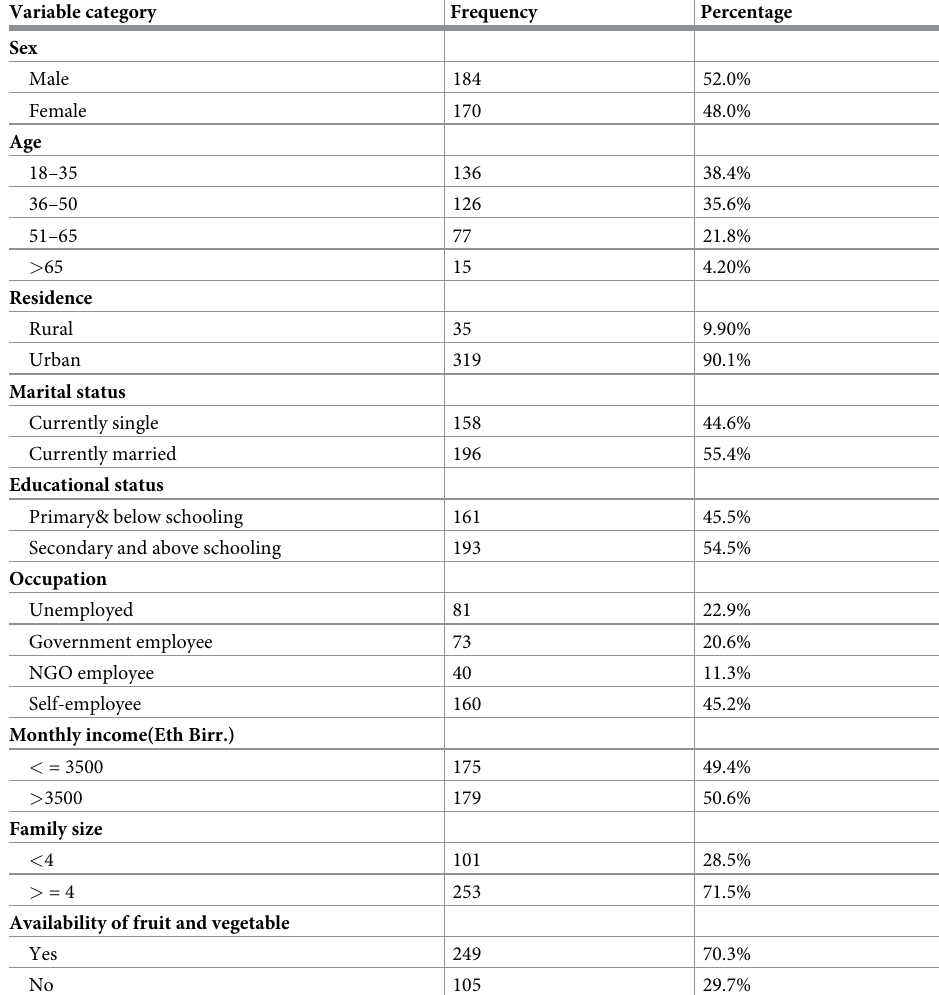
Table 1. Socio-demographic characteristics of diabetic patients in JUMC, 2020. Variable